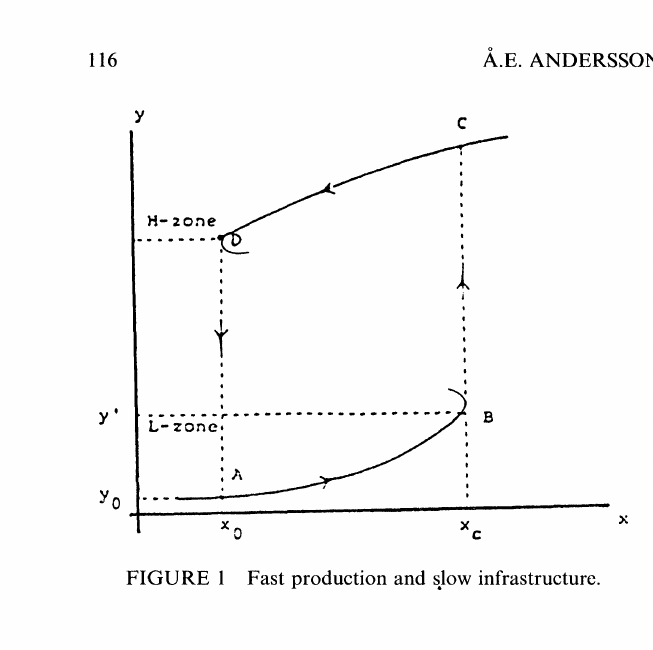
FIGURE Fast production and s.low